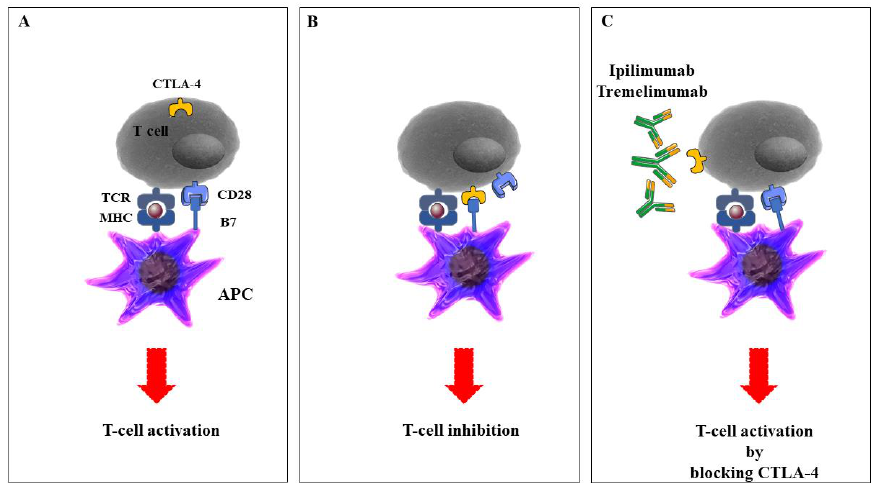
Figure 1. The role of cytotoxic T-lymphocyte-associated protein 4 (CTLA-4) inhibitors in the activation of T cells. A: Antigen-presenting cells (APCs), including dendritic cells (DCs), macrophages, natural killer (NK) cells, and B cells, process tumor antigens and present them to specific T cells, leading to activation of the T cells and immune responses to the tumor. B: Upon T cell receptor activation, CTLA-4 is expressed on the T cell surface and interacts with the co-receptor CD28 that is expressed on APCs, leading to the end of the T cell responses. C: Anti-CTLA-4—specific monoclonal antibodies prevent the interaction between CTLA-4 and CD28 and contribute to inhibitory signals in T cells. The figure was produced using Servier Medical Art (http://smart.servier.com/).